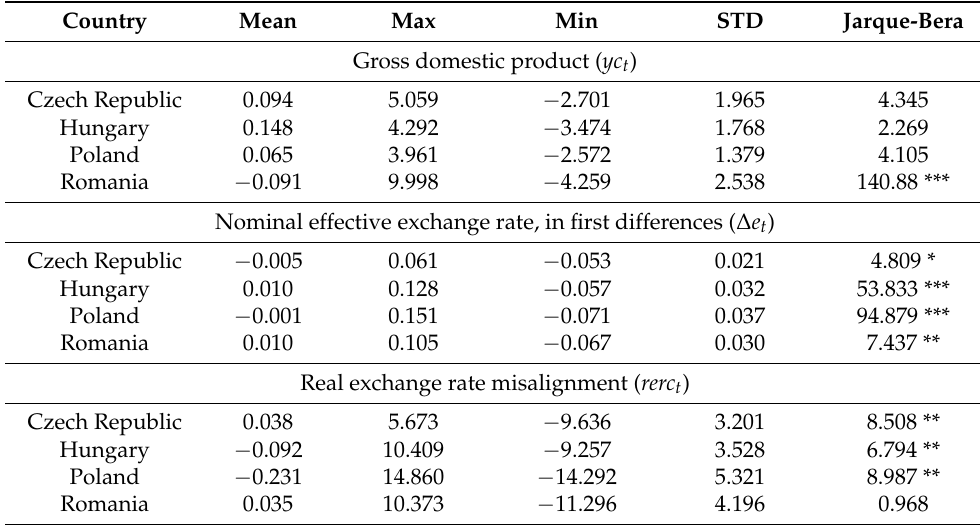
Table 1. Descriptive statistics.